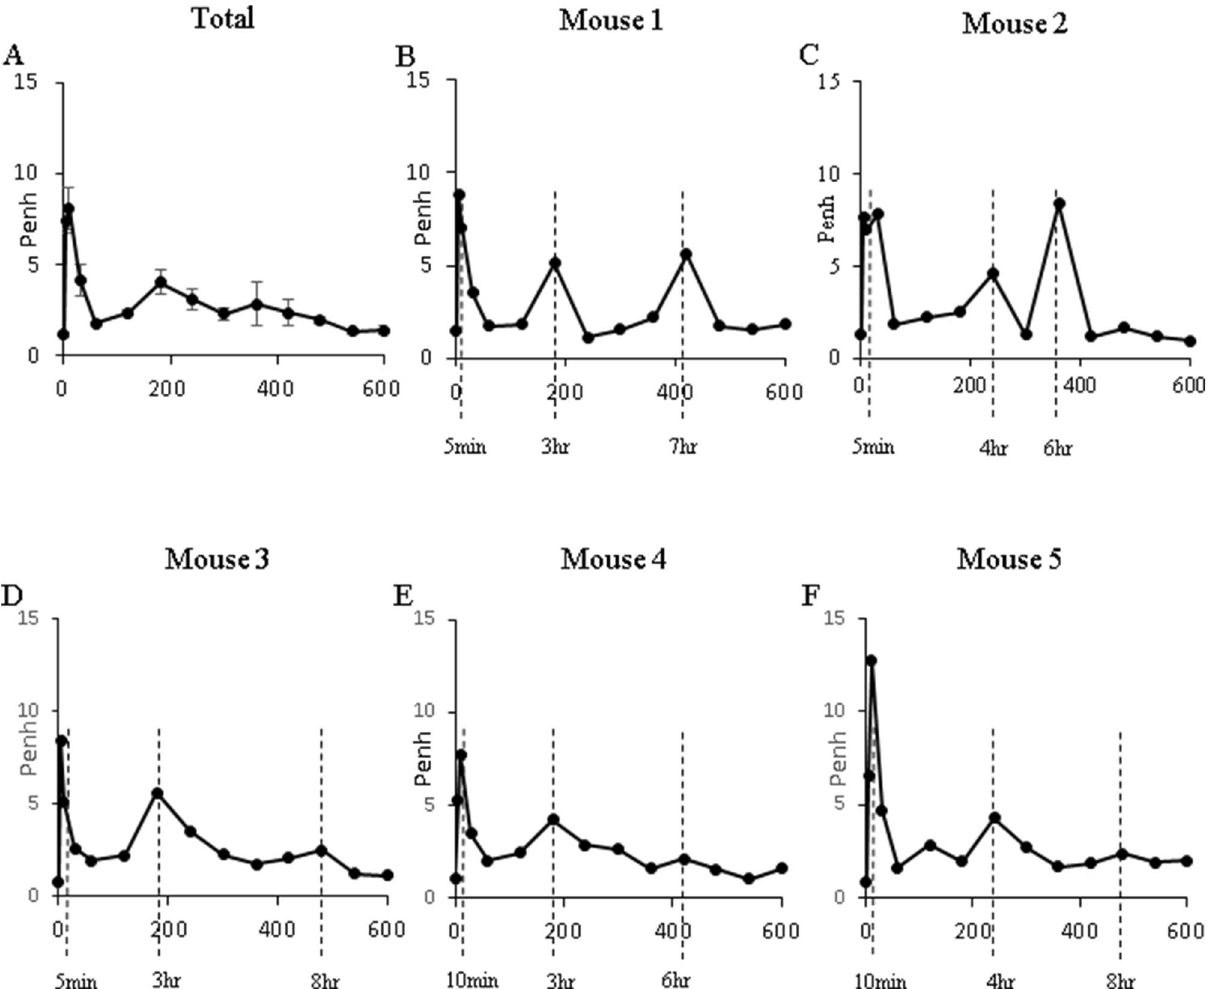
Figure 4. Serial changes of Penh up to 10 h after OVA challenge. (A) Serial mean Penh after OVA challenge. (B–F) Penh change in each mouse 1–5. As all together, two peaks representing EAR and LAR were observed. However, interestingly some mice showed multiple peaks of